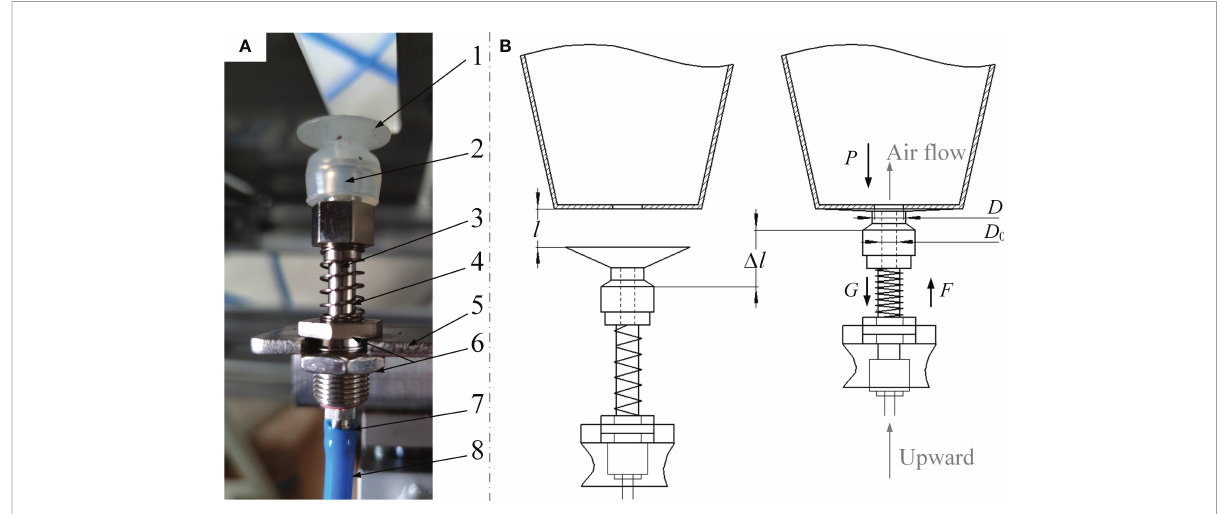
FIGURE 3 Determination of the air fl ow nozzle device. (A) The structure of air fl ow nozzle (B) Design of the pneumatic ejector device.